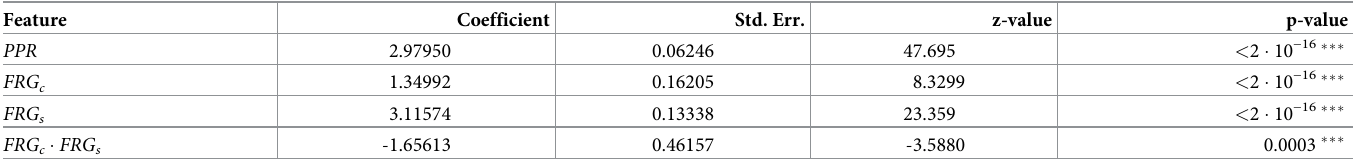
Table 2. Example coefficients for one instance of the network